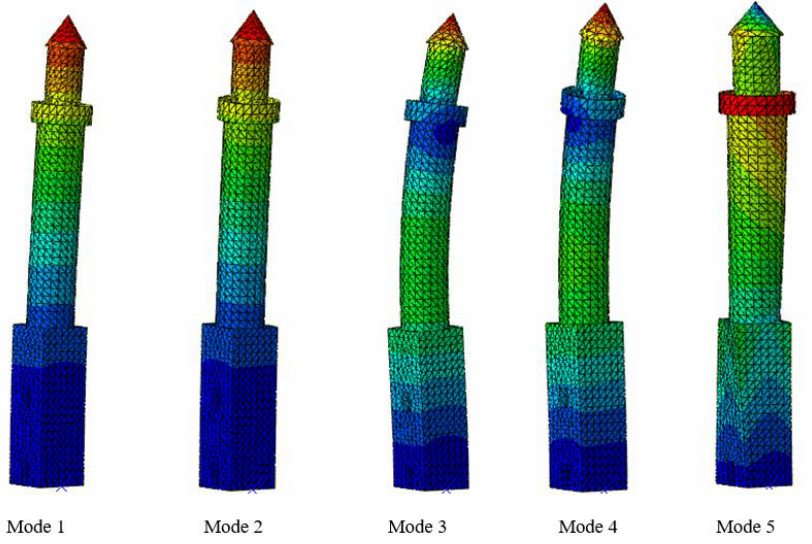
Figure 7. Mode shapes obtained for the sample minaret (H = 25.40 m).